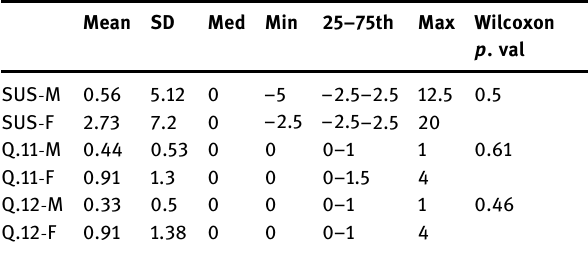
Table 8: Question 12 – The robot teaching system helped me understand how behaviours can interfere with each other ( no. of persons )